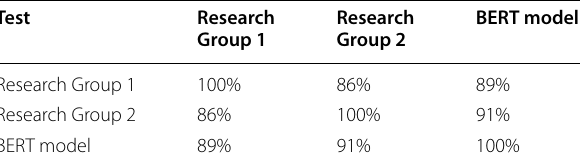
Table 3 Fits manual classification and the BERT model